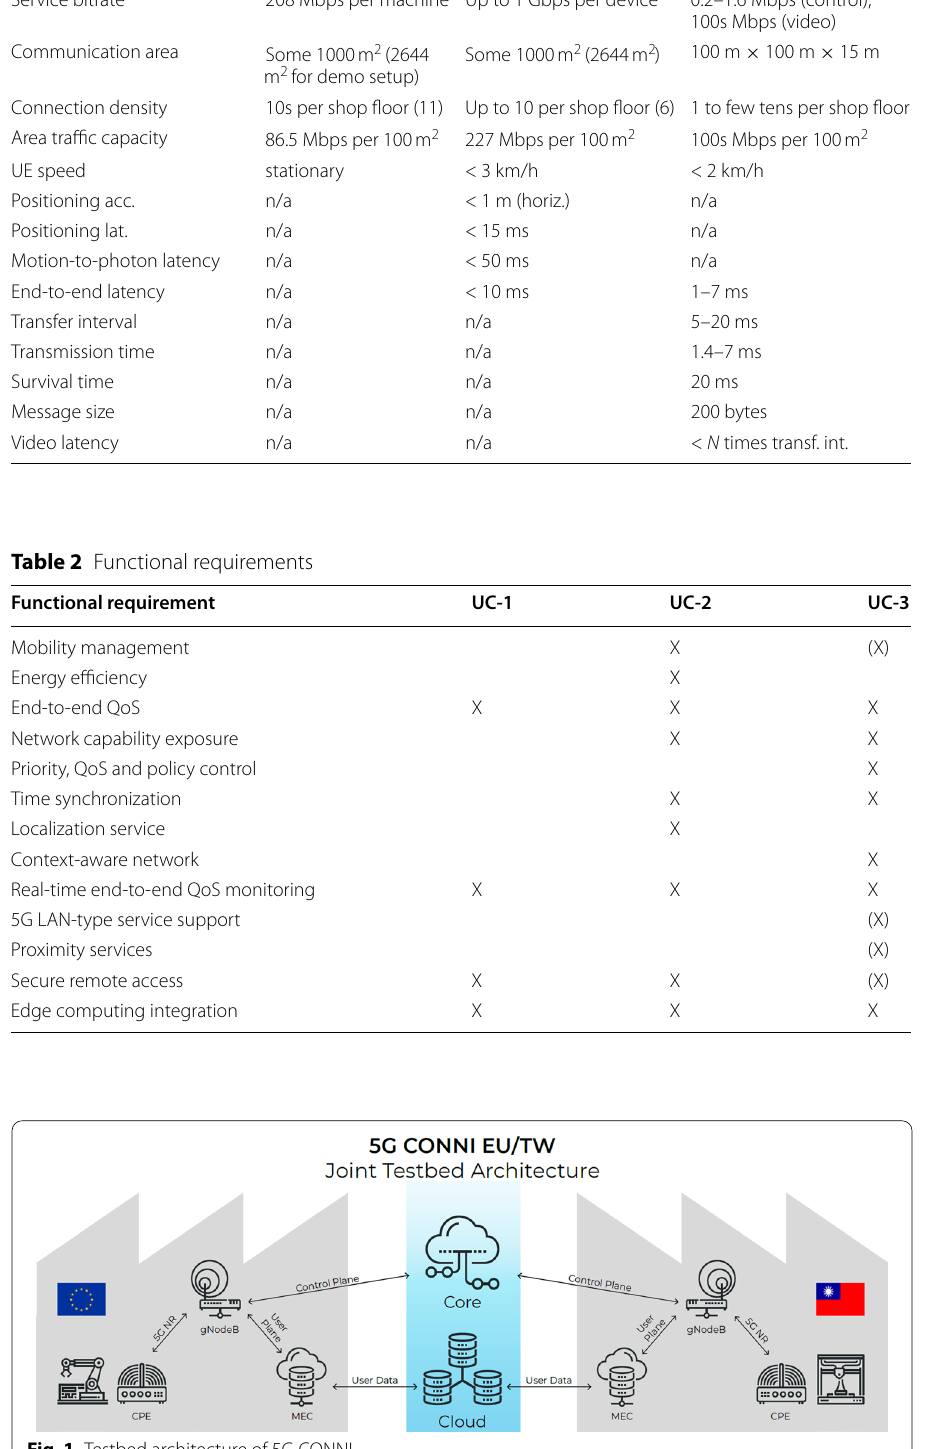
Fig. 1 Testbed architecture of 5G